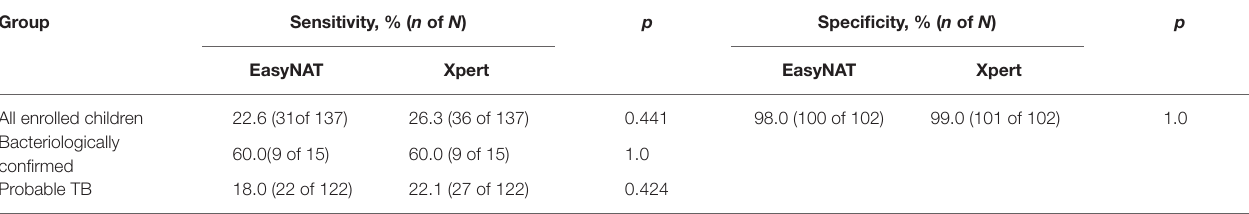
TABLE 2 | Comparison of EasyNAT and Xpert in children with TB and RTIs. Group Sensitivity, % ( n of N ) p